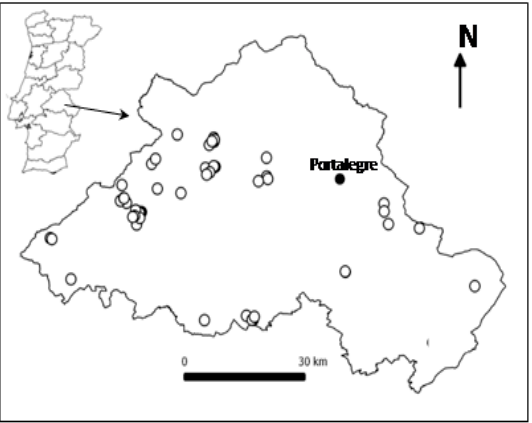
Figure 2. Spatial distribution of the charcoal production sites in the Portalegre